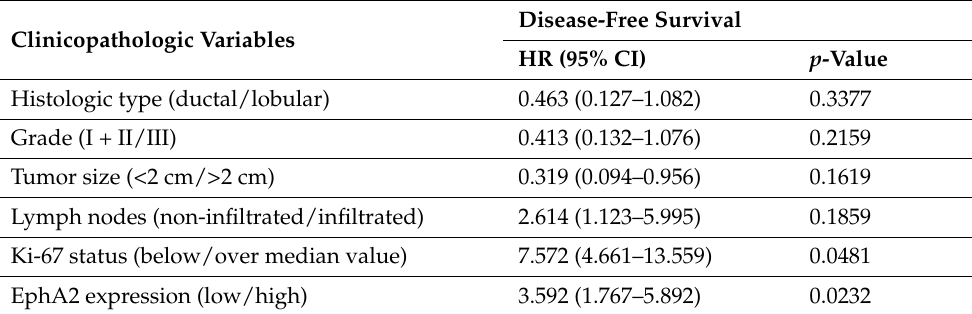
Table 5. Multivariate analysis for histologic type, grade, tumor size, lymph node status, Ki-67 status, and EPHA2 expression for DFS.